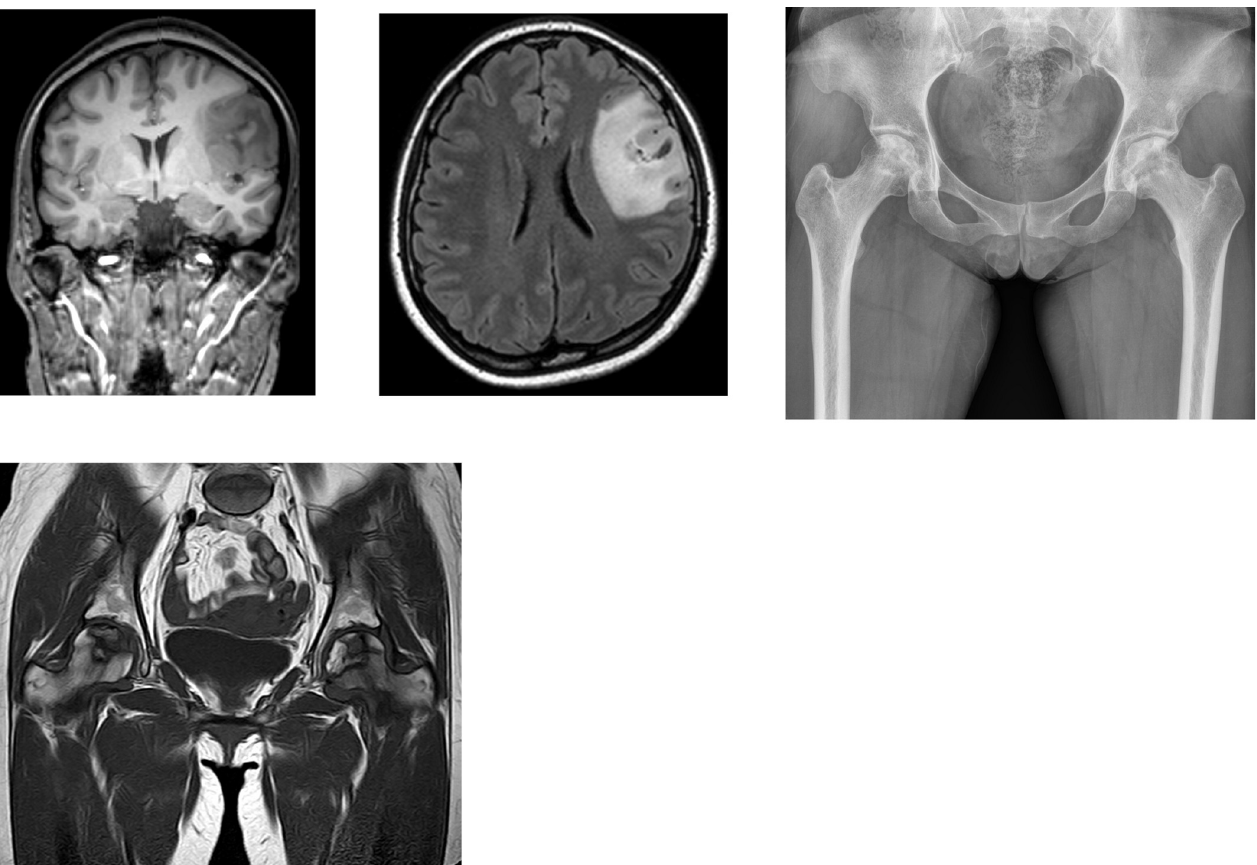
Fig 2. Example of a newly diagnosed osteonecrosis of the femoral head in brain tumor patient. (A, B) Brain magnetic resonance imaging (MRI) of a 25-year old woman who had generalized tonic–clonic seizures, revealed a tumor in the left frontal lobe. She was diagnosed with pathology-confirmed